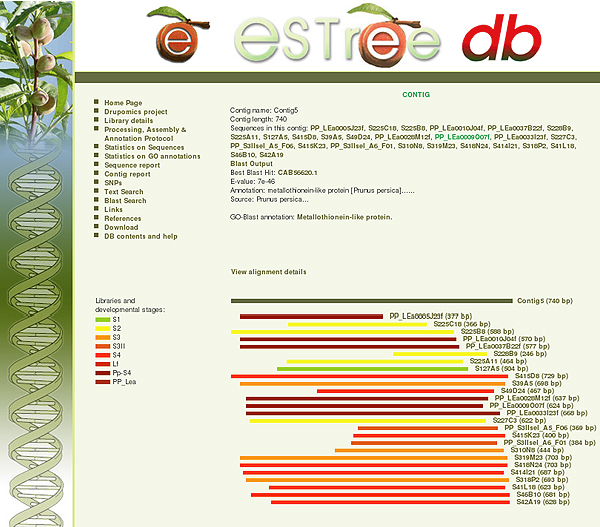
The ESTree db Contig display page. An example of the ESTree db contig graphical display. The bar colours reflect the developmental stage of the sequence clone library of origin. The same colours recur in the AutoSNP output and in the library details. The graphical display is dynamically created by the php web interface.